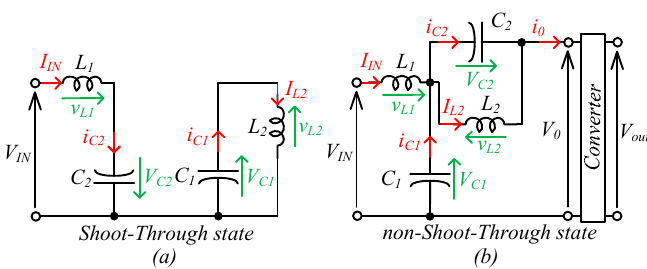
Figure 3. Equivalent circuits of the quasi-Z-source network: ( a ) The shoot-through (ST) state and ( b ) the non-ST state. Table 1. Summarized equations for selected topologies.